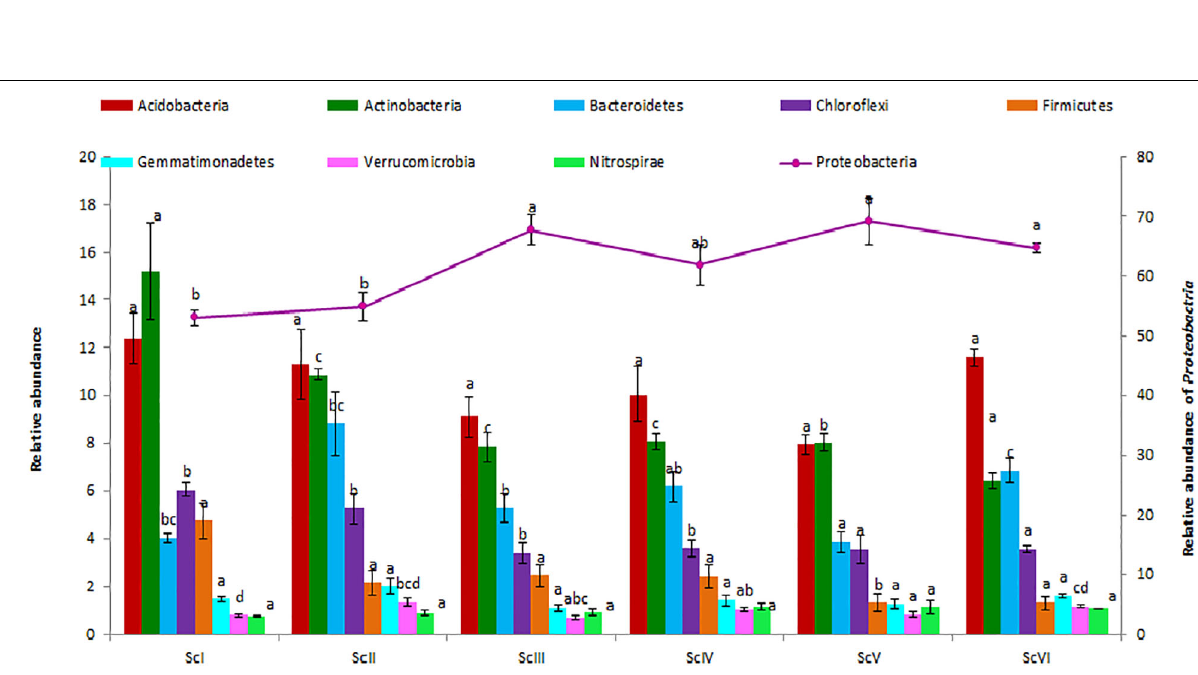
FIGURE 3 | Distribution of different dominating phyla ( > 1%) in different agriculture management scenarios. Where ; ScI, conventional rice-wheat system; ScII, partial CA based rice-wheat-mungbean system; ScIII, partial CSA based rice-wheat-mungbean system; ScIV, partial CSA based maize-wheat-mungbean system; ScV, full CSA based rice-wheat-mungbean system with sub surface drip irrigation; ScVI, full CSA based maize-wheat-mungbean system with sub surface drip irrigation. The same letters within each column are not statistically different between scenarios for each phylum ( P ≤ 0.05, Duncan’s multiple range test) and values are the average of three replicates ( n = 3); means ± standard error